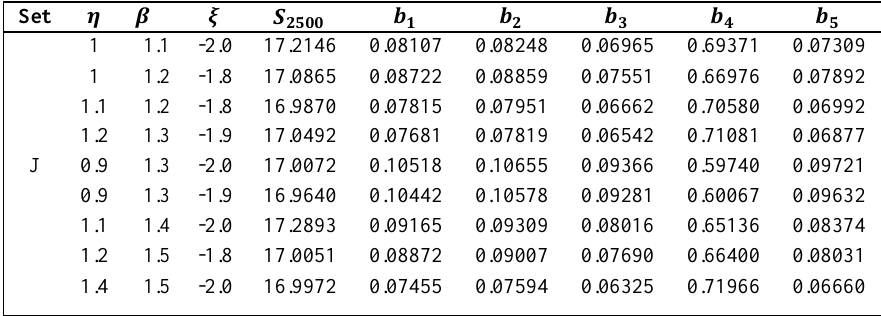
Table 3. The best wealth 𝑆 2500 obtained after 2500 trading days by running the universal portfolio generated by rational functions (9) over the data set J, K, L, M, N for selected value of 𝜂 , 𝛽 , 𝜉 , 𝑐 = 0.1 and the final portfolios after 2500 trading days 𝒃 2501 are